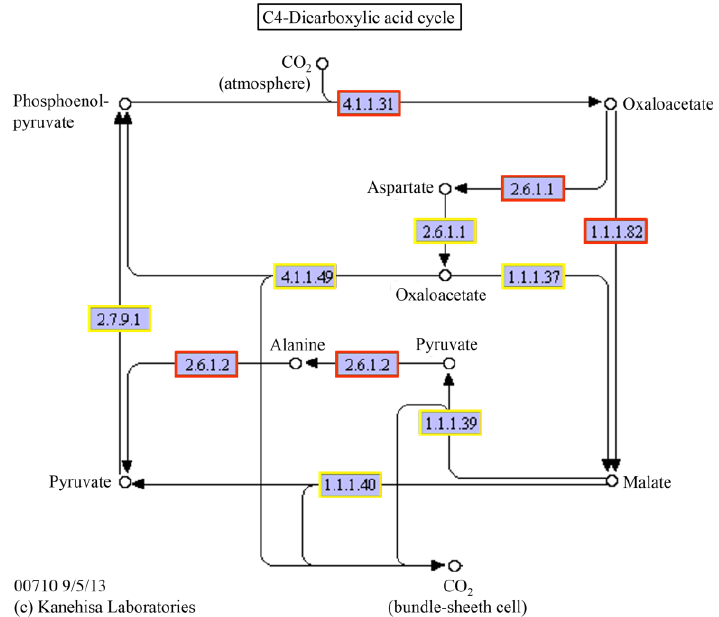
Figure 16. C4-dicarboxylic acid cycle pathway in P. kessleri FACHB-3316 generated by KEGG. (The red boxes indicate the ko nodes containing the up-regulated differential gene enzymes; the orange boxes indicate the ko nodes containing up- and down-regulated differential gene enzymes.).